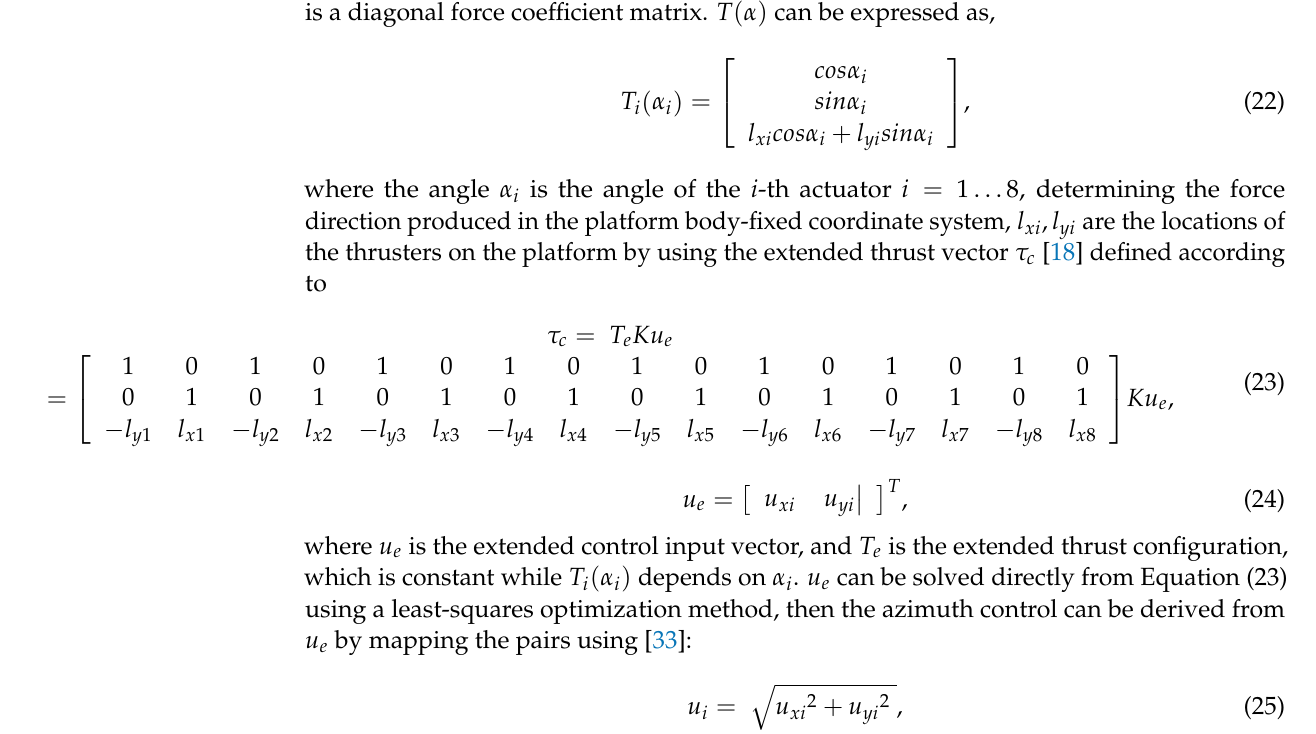
Figure 4. Wind load coefficients.